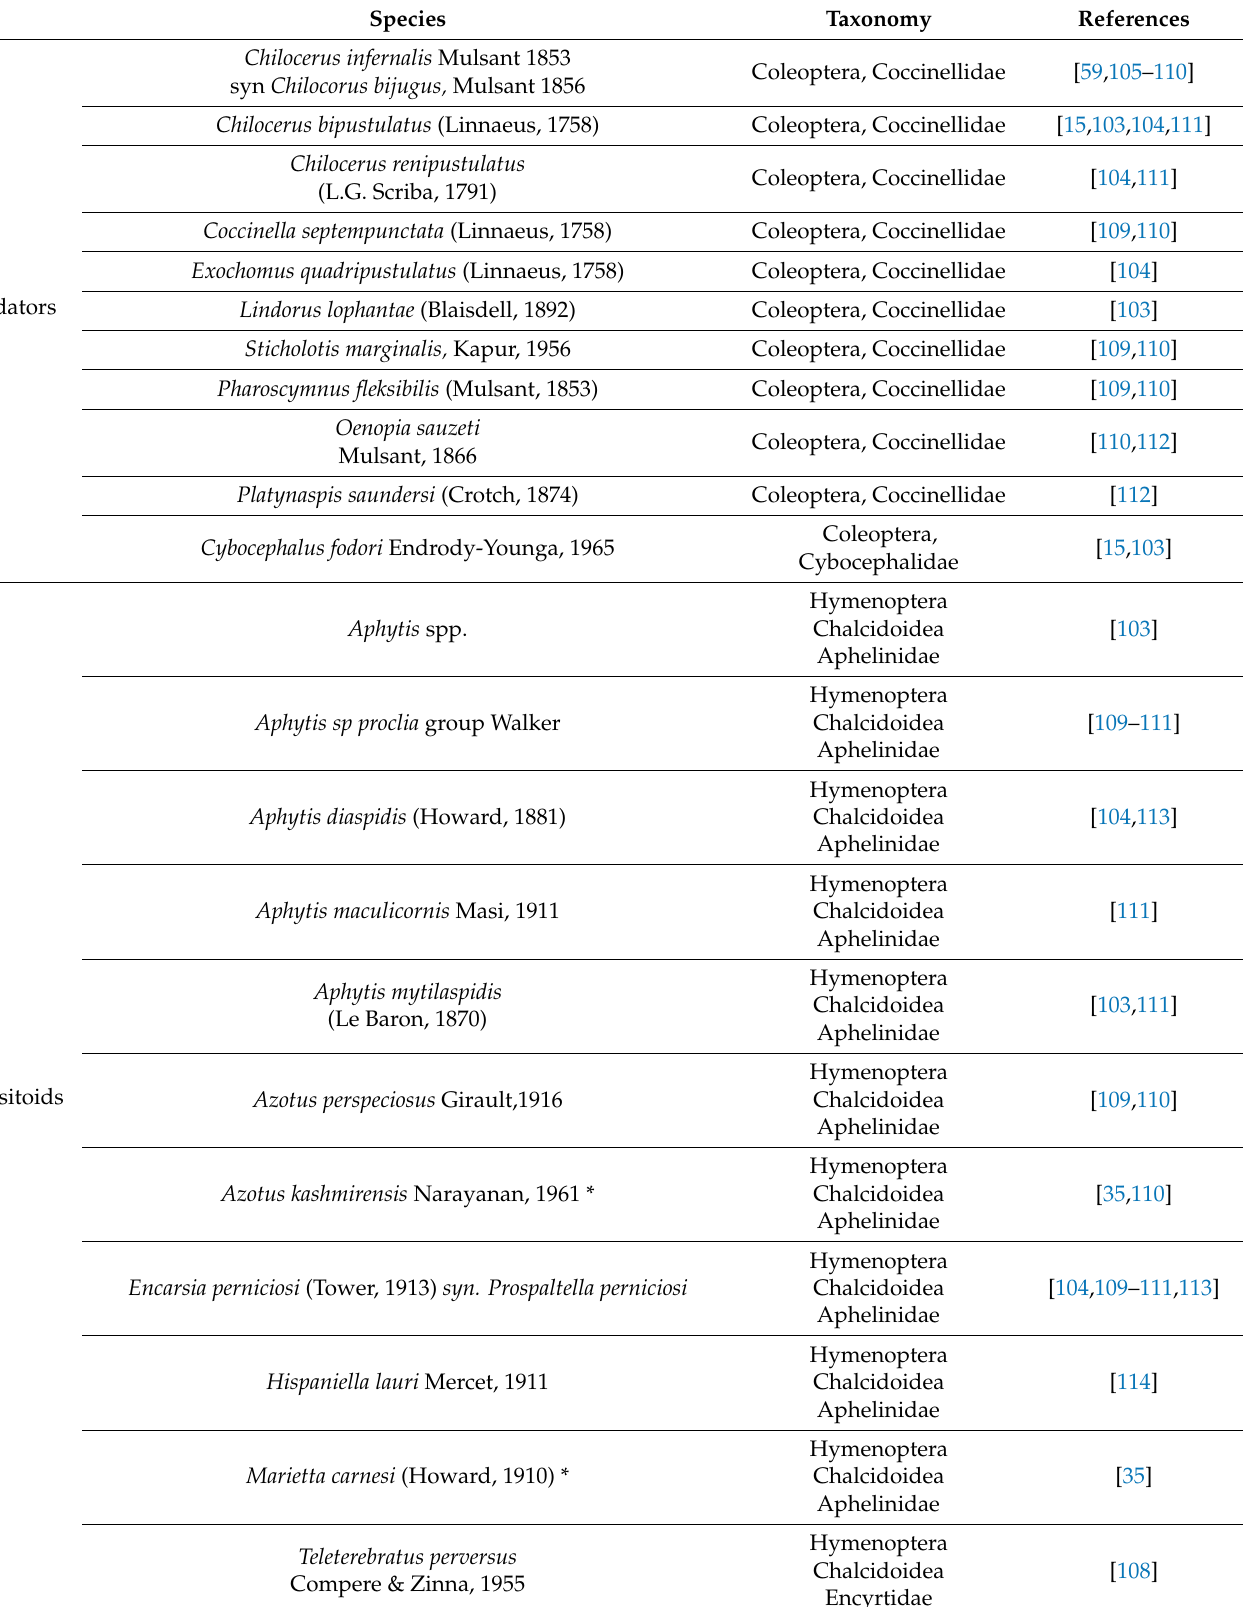
Table 2. Predators and parasitoids recorded from C. perniciosa based on literature data.